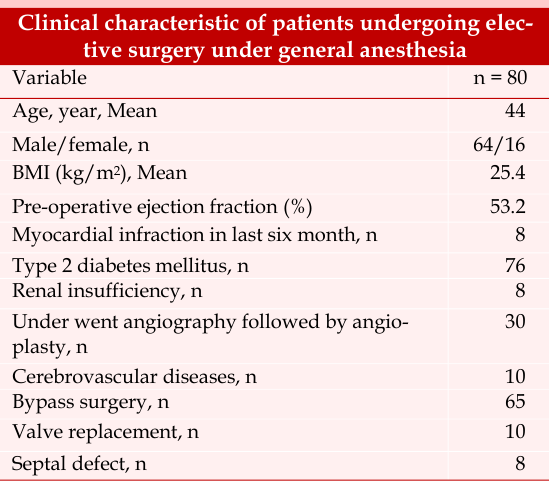
Clinical characteristic of patients undergoing elec- tive surgery under general